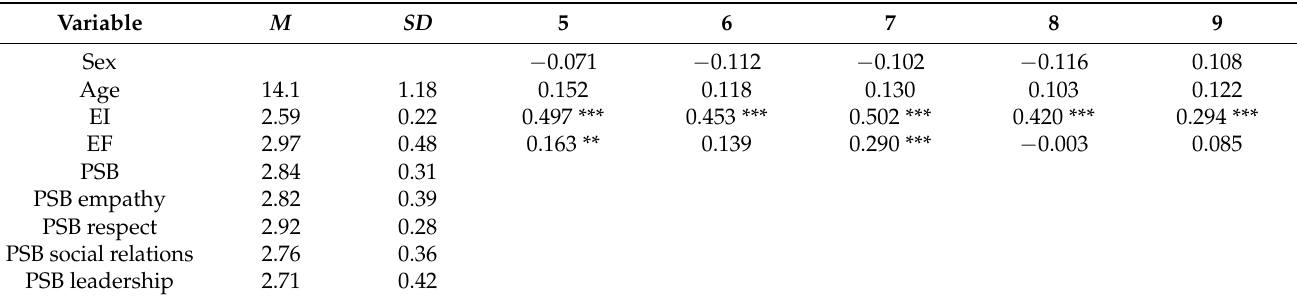
Table 2. Mean, standard deviation and Pearson correlations between study variables (N =